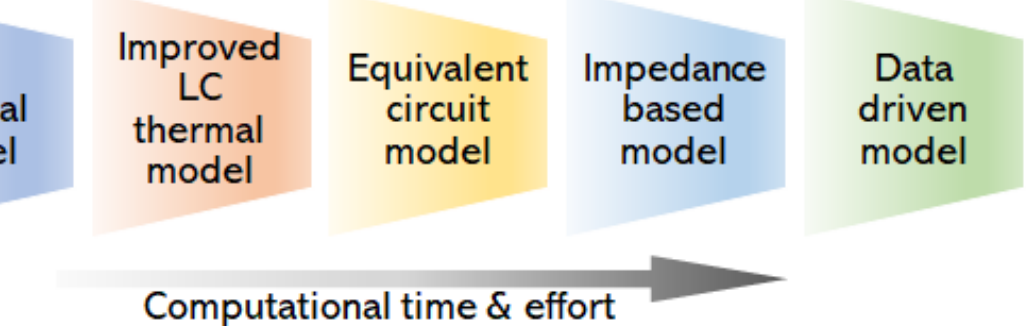
Figure 15. Assessments of computational time and effort of the five modeling approaches.